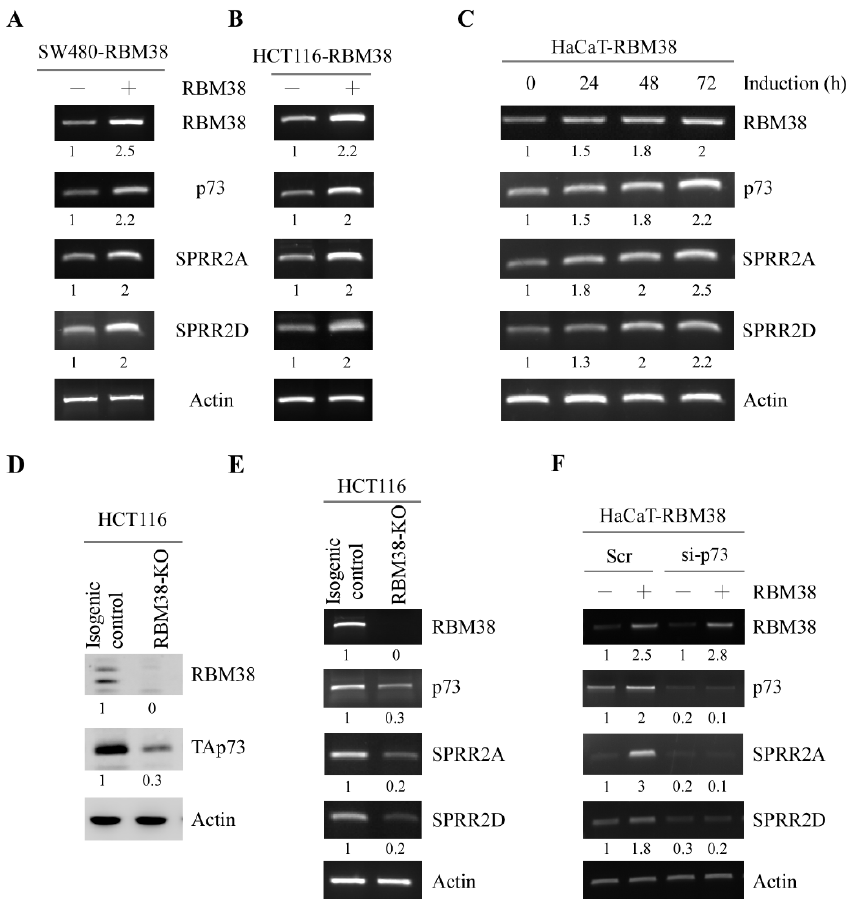
Figure 1. RBM38 regulates SPRR2A/2D expression via p73. ( A–B ) SW480 ( A ) and HCT116 ( B ) cells were uninduced or induced to express RBM38 for 24 h, followed by RT ‐ PCR analysis to examine the levels of RBM38, p73, SPRR2A, SPRR2D, and actin transcripts. ( C ) HaCaT cells were induced to express RBM38 from 0 to 72 hours, followed by RT ‐ PCR analysis to examine the levels of RBM38, p73, SPRR2A, SPRR2D, and actin transcripts. ( D ) The levels of RBM38 and p73 protein were examined in isogenic control and RBM38 ‐ KO HCT116 cells by Western blot analysis. ( E ) The levels of RBM38, p73, SPRR2A, SPRR2D, and actin transcripts were examined in isogenic control and RBM38 ‐ KO HCT116 cells by RT ‐ PCR analysis. ( F ) HaCaT cells were transiently transfected with a control or p73 siRNA for 48 hours, followed with or without induction of RBM38 for 24 hours. RT ‐ PCR analysis was performed to examine the levels of RBM38, p73, SPRR2A, SPRR2D, and actin transcripts.